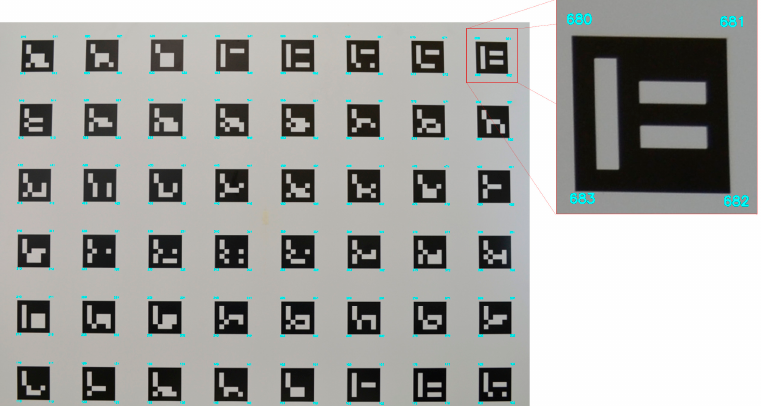
Figure 3. Panel composed of Aruco targets used for camera calibration, showing the corners that were automatically extracted.